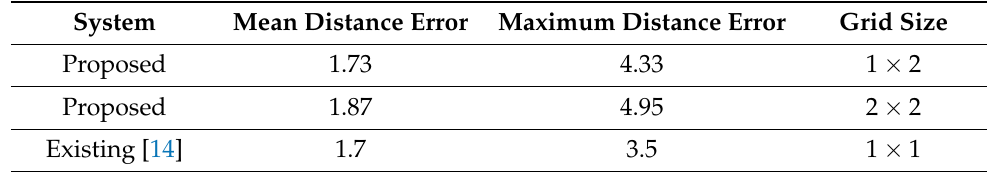
Table 13. Comparing with existing